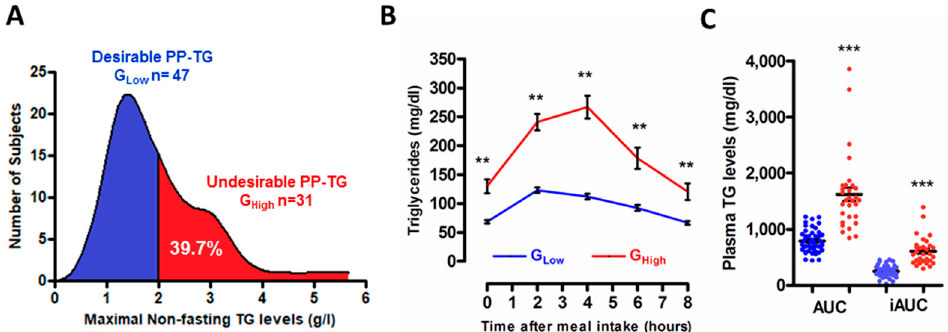
Figure 1. Postprandial triglyceride (TG) response following consumption of a typical solid mixed meal. Distribution of nonfasting TG levels in normolipidemic men from the postprandial high-density lipoprotein (HDL-PP) cohort ( n = 78) . Subjects were divided into two subgroups according maximum nonfasting TG levels below or above the cut-off value of 1.8 g/L (2 mmol/L) identifying subjects with a desirable postprandial TG response (G Low , below 1.8 g/L; n = 47) or an undesirable postprandial TG response (G High , above 1.8 g/L; n = 31) ( A ). Postprandial time course of plasma triglyceride levels in response to the ingestion of the test meal in subjects from G Low (blue curve) and G High (red curve) ( B ). Area under the curve (AUC) and incremental AUC (iAUC) in subjects from G Low (blue dots) and G High (red dots) ( C ). Values are mean ± SEM. *** p < 0.0001 and ** p < 0.001 versus G Low.